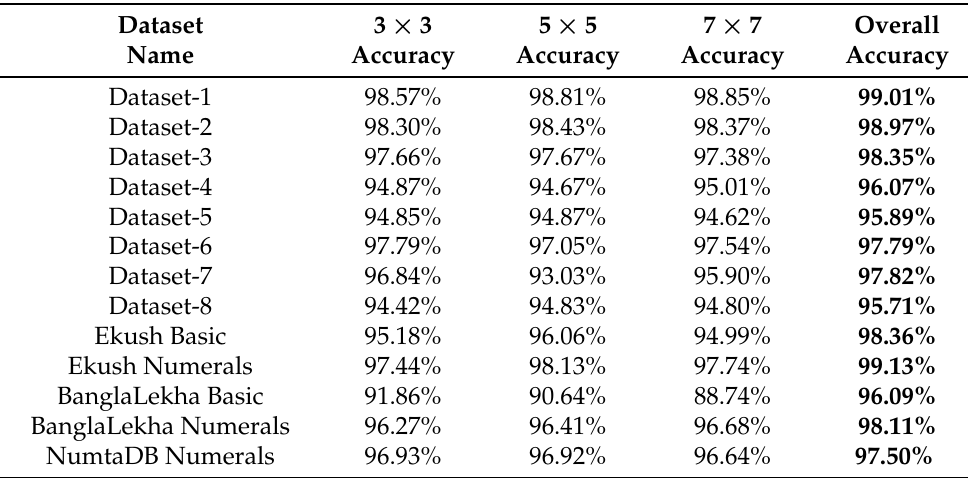
Table 6. Comparison of performance among individual and BengaliNet architectures for the consid- ered